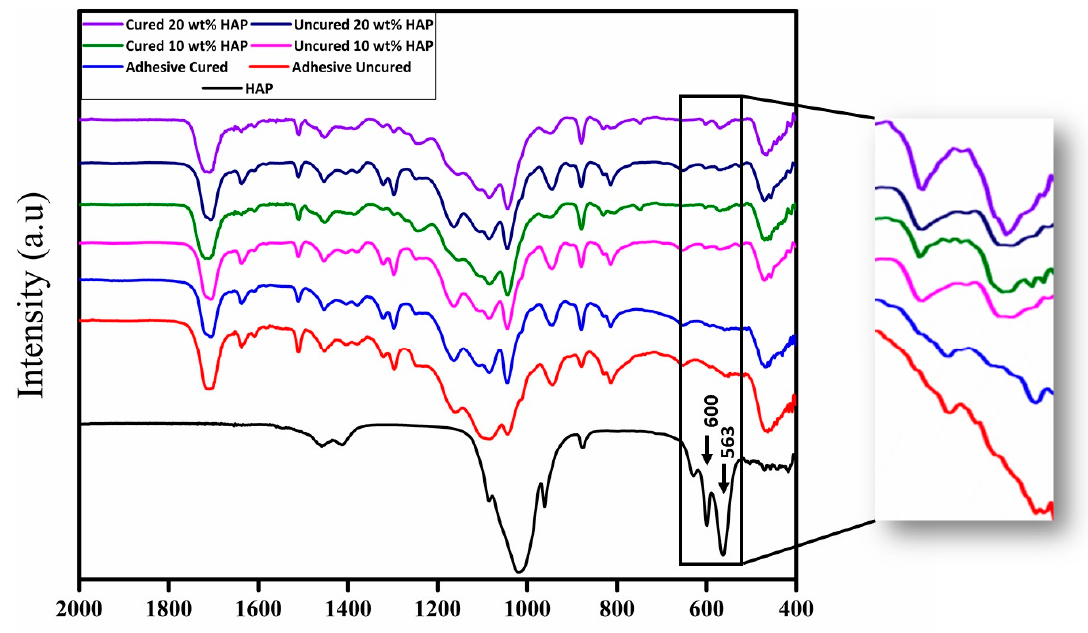
Figure 3. FTIR spectra of the HA nanoparticles, unmodified and modified EAs having low (10 wt.%) and high (20 wt.%) percentage of HA particles. The characteristic peaks at 563 and 600 cm − 1 show evidence of the presence of HA in the uncured and cured dentin adhesive. Reprinted with permission from Al-Hamdan et al. [33]. Copyright 2020 MDPI.